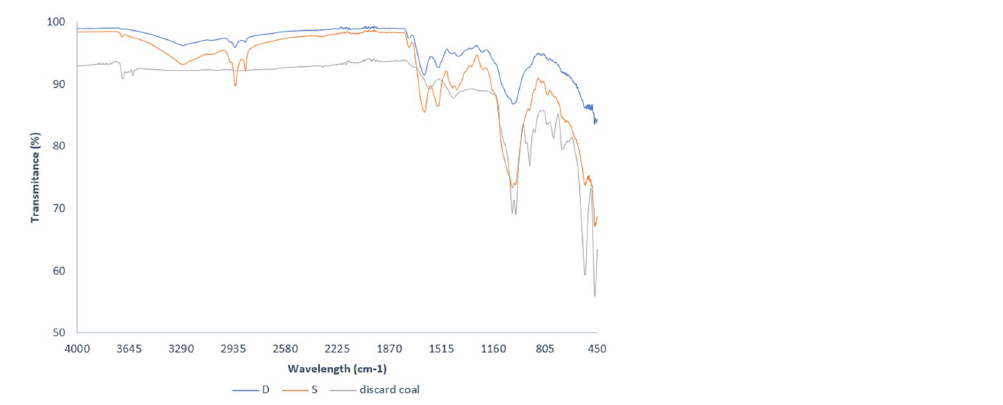
Figure 5. FT-IR spectra for precursors D